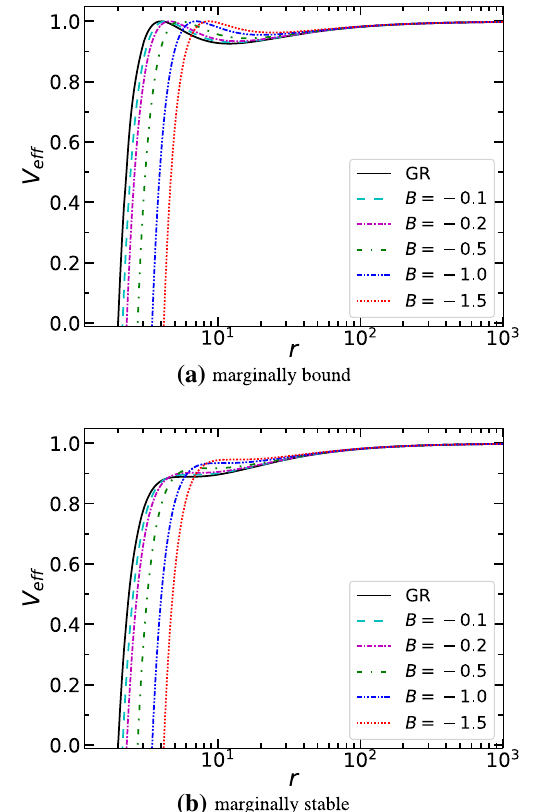
Fig. 4 Effective potential for marginally bound and marginally stable circular orbits. All the quantities are expressed in dimensionless unit with c = G = M = 1